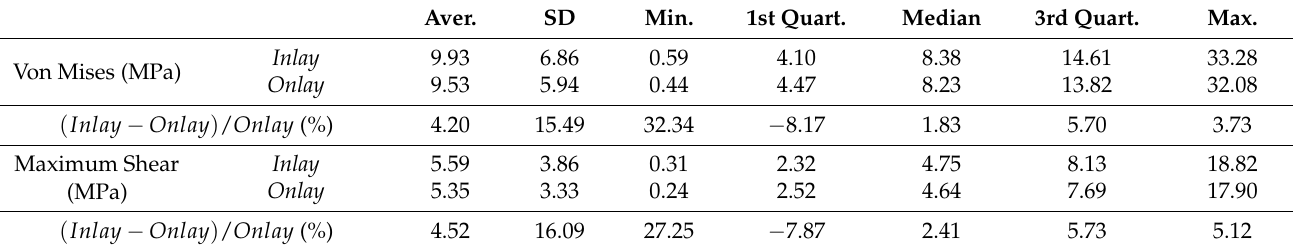
Table 5. Statistical description of the stress distributions for the resin cement adhesives. Aver. SD Min. 1st Quart. Median 3rd Quart. Max.